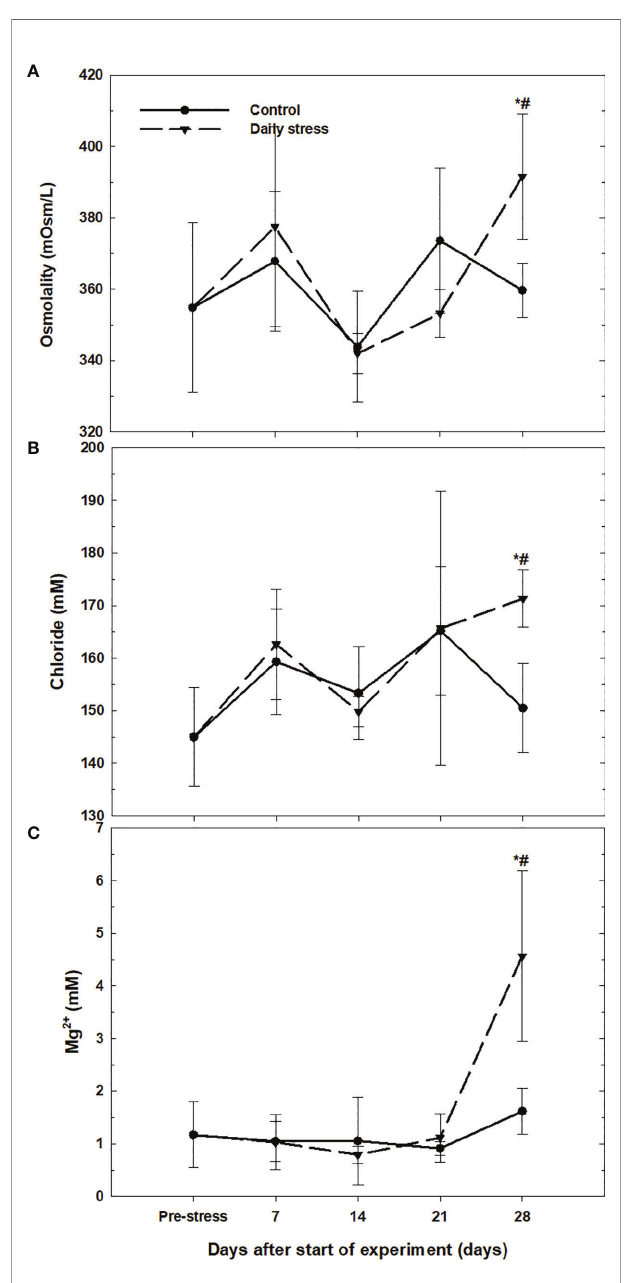
FIGURE 2 | (A) Plasma osmolality (mean ± SD, n = 6) in the control group ( fi lled circles) and daily stress group ( fi lled triangles) in lump fi sh during the 28 day trial. (B) Plasma chloride (mean ± SD, n = 6) in the control group ( fi lled circles) and daily stress group ( fi lled triangles) in lump fi sh during the 28 day trial. (C) Plasma magnesium (mean ± SD, n = 6) in the control group ( fi lled circles) and daily stress group ( fi lled triangles) in lump fi sh during the 28 days trial. # indicates signi fi cant difference between groups at the same sampling day at 95% con fi dence level, * indicates signi fi cant difference from the pre- stress level at 95% con fi dence